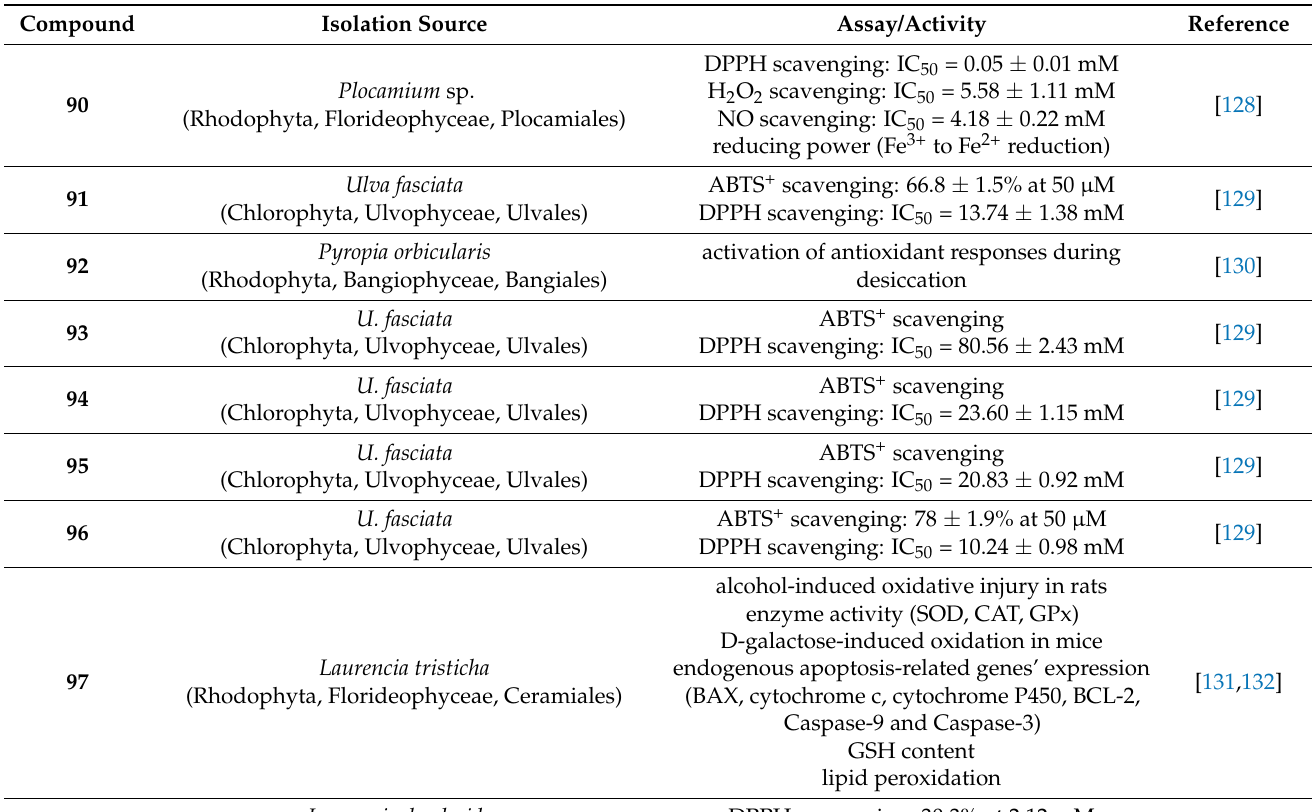
Table 3. Terpenoids from macroalgae with antioxidant